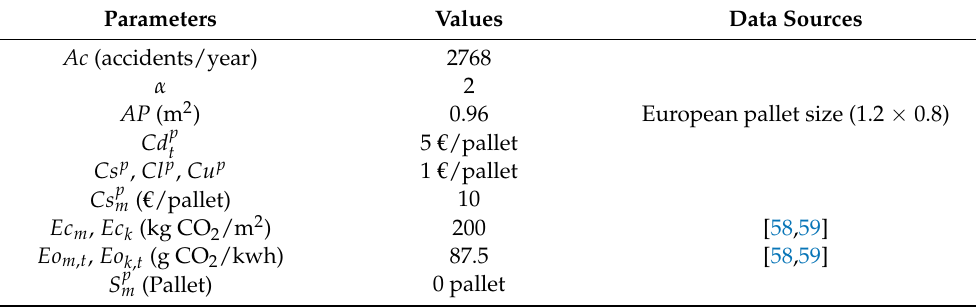
Table 4. Other used data.